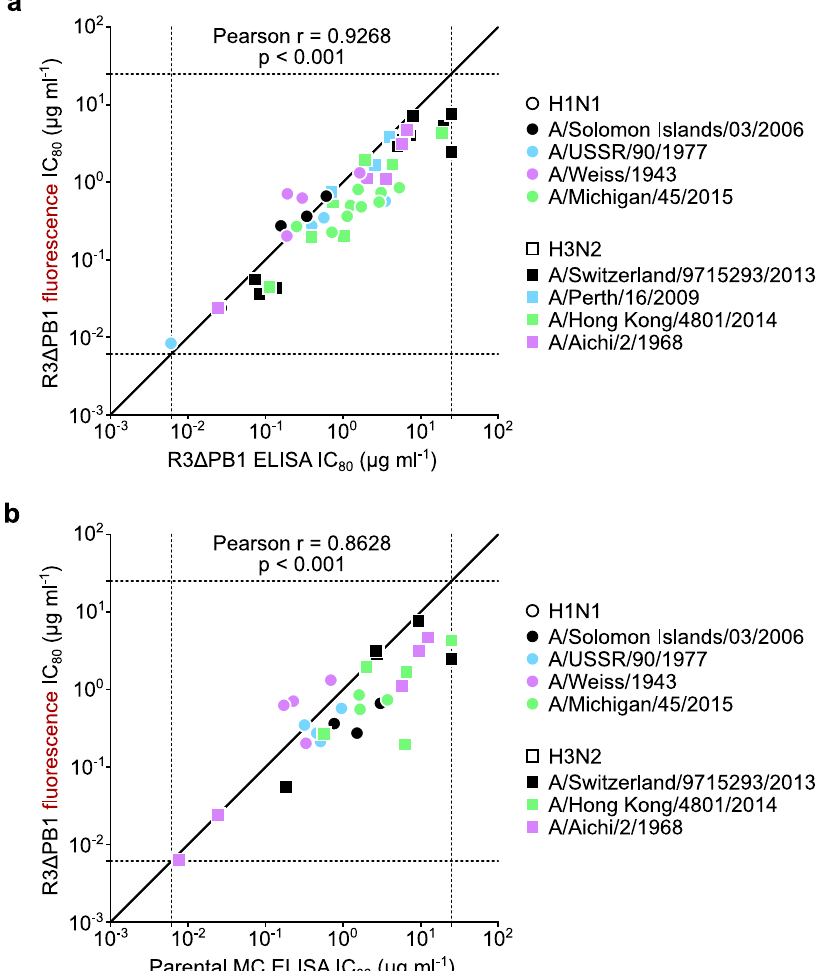
Fig. 2 Assessment of R3 Δ PB1 virus for neutralization assay. a Correlation between fl uorescence- and ELISA-based readouts. Each dot indicates the neutralization titers (IC 80 µ g ml − 1 ) of a single monoclonal antibody against an R3 Δ PB1 in fl uenza virus measured by fl uorescence readout ( y -axis) and ELISA with anti-NP antibody ( x -axis). b Correlation between assays using R3 Δ PB1 and molecular clone (MC) viruses. Each symbol indicates the neutralizing activity (IC 80 µ g ml − 1 ) of a single monoclonal antibody using R3 Δ PB1 ( y -axis) and parental MC viruses ( x -axis) expressing the same HA and NA. Colors indicate different viruses. Circles and squares represent H1N1 and H3N2 viruses, respectively. Dashed lines indicate upper and lower limits of detection. Pearson r correlation coef fi cient and two-tailed p values for each analysis are shown above each graph. Neutralization assays were performed at least twice and representative data are